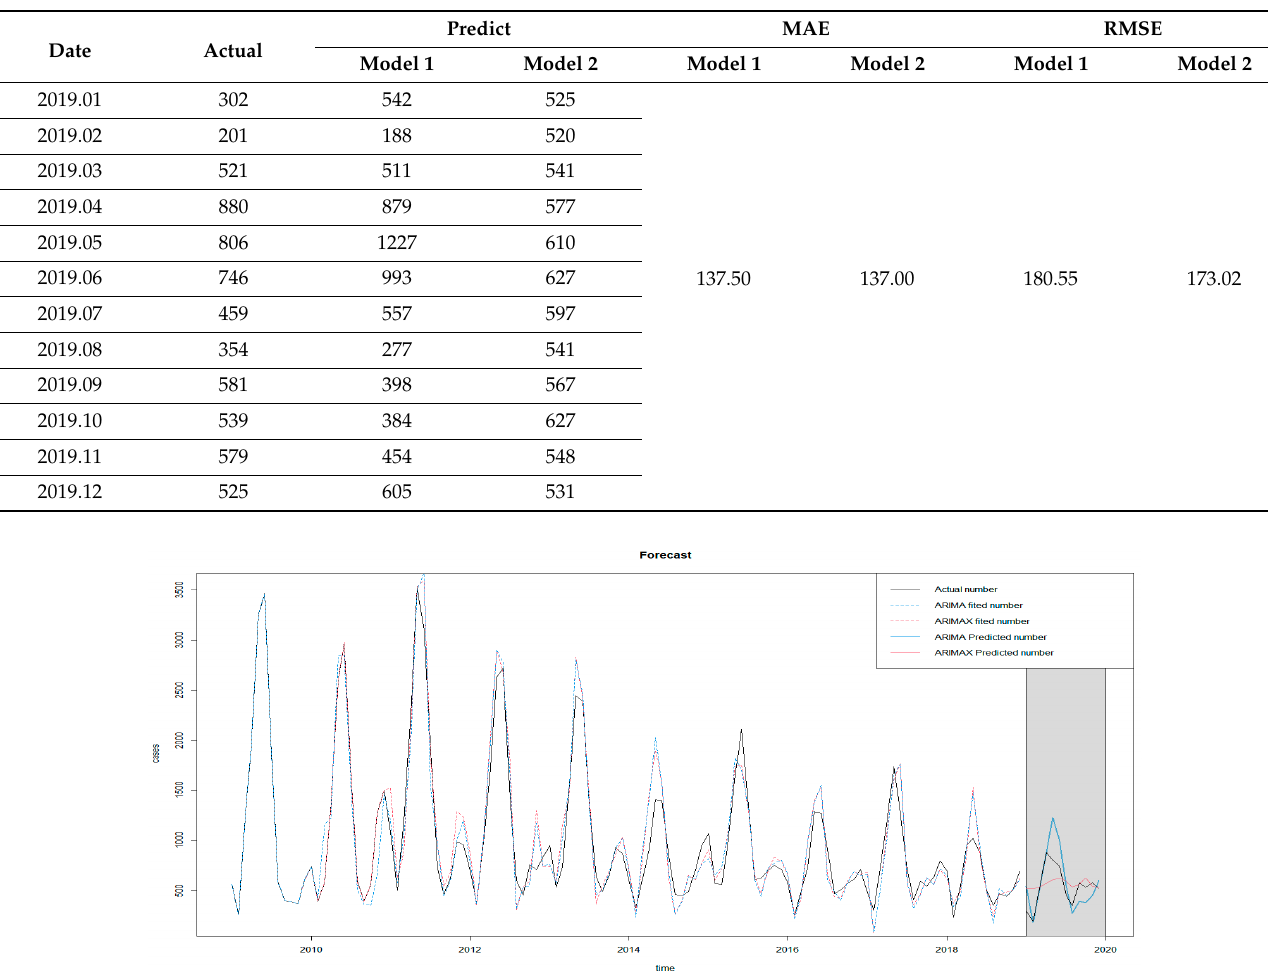
Figure 5. Prediction diagram of ARIMA and ARIMAX. Table 5. MAE and RMSE of prediction by ARIMA and ARIMAX models.